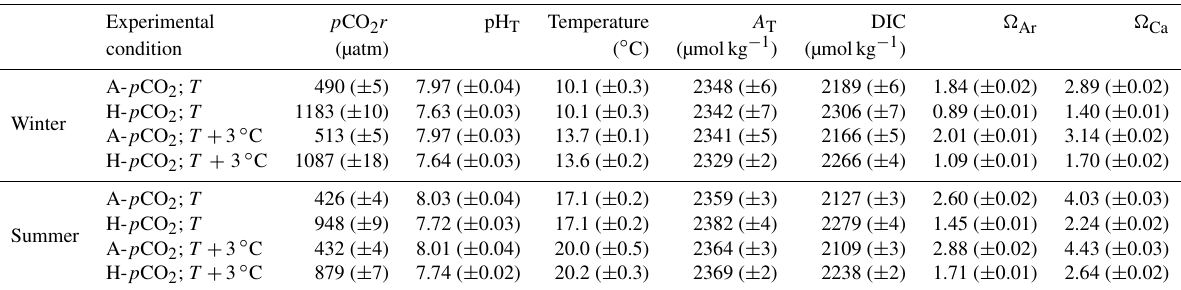
Table 2. Physicochemical parameters (mean ± SE) of seawater in each experimental condition (A- p CO 2 is ambient p CO 2 ; H- p CO 2 is high p CO 2 ; T is ambient temperature; T + 3 ◦ C is high temperature) in the winter and the summer. pH T and temperature were monitored every 2 days in each aquarium ( n = 35). Total alkalinity values ( A T ) are means ( ± SE) of 28 samples measured in each aquarium. The CO 2 partial pressure ( p CO 2 ) , dissolved inorganic carbon (DIC), and saturation states of seawater with respect to aragonite ( (cid:127) Ar ) and calcite ( (cid:127) Ca ) were calculated from pH T , temperature, salinity, and A T using